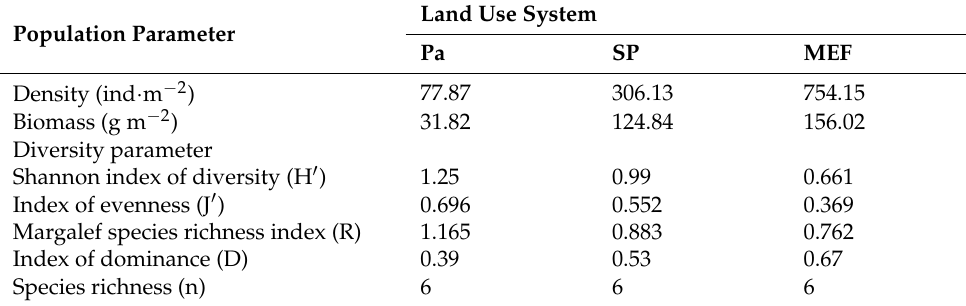
Table 11. The relationship between diversity, density, and biomass of earthworms. Population